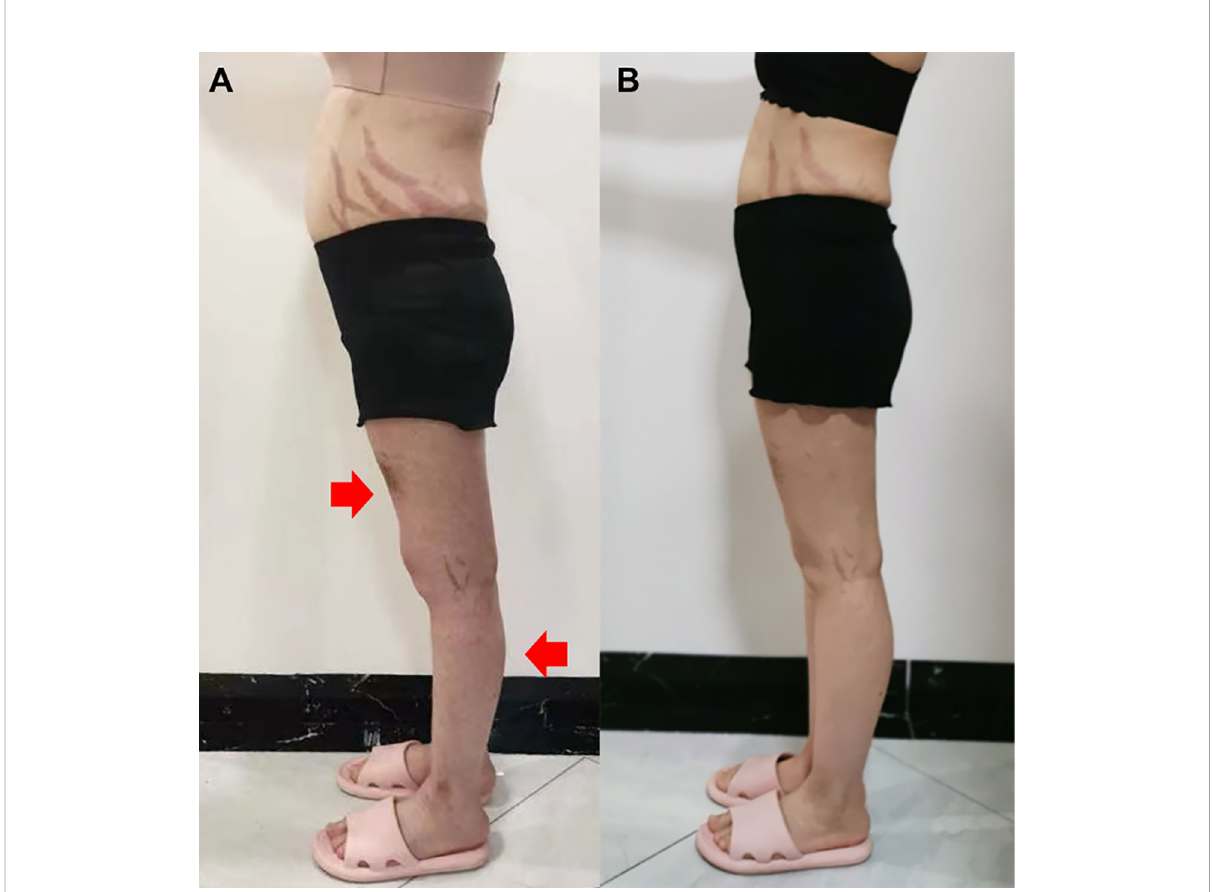
FIGURE 1 Side view of the patient before glucocorticoid decrement (A) and 1 year after glucocorticoid decrement (B) . Arrows indicate sites with apparent muscle